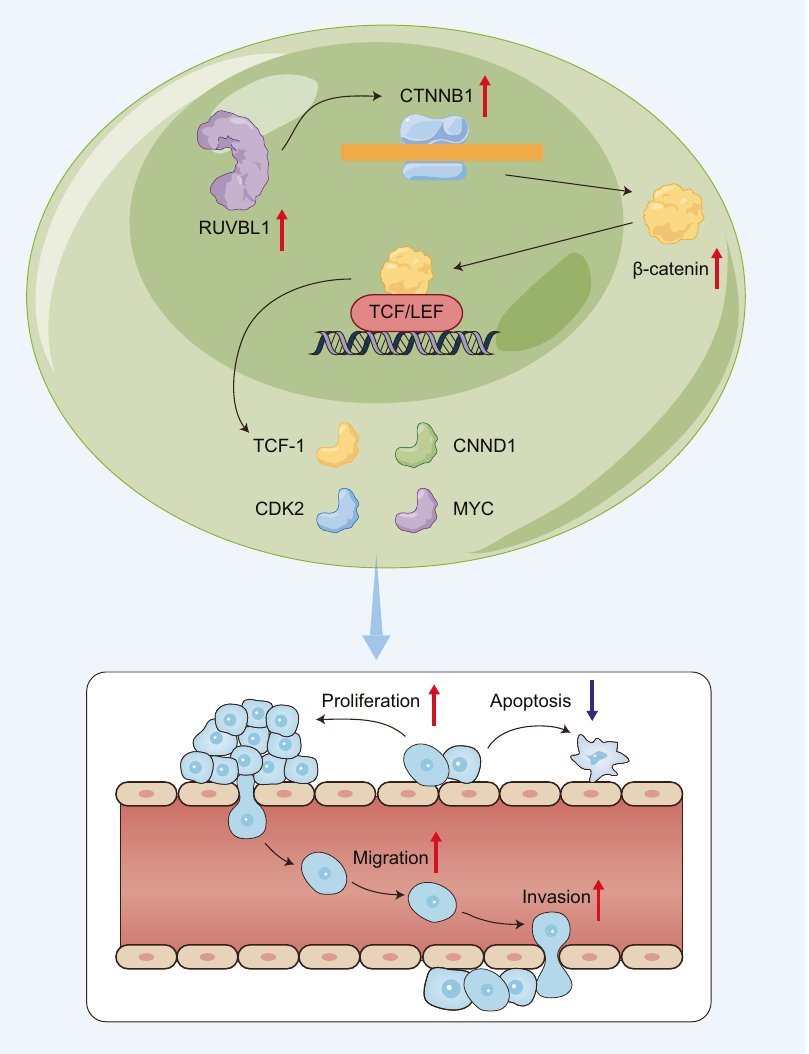
Fig. 7 Molecular mechanism graph of RUVBL1 in UVM, where RUVBL1 promotes the transcriptional activity of CTNNB1 through chromatin remodeling, leading to augmented malignant phenotypes of